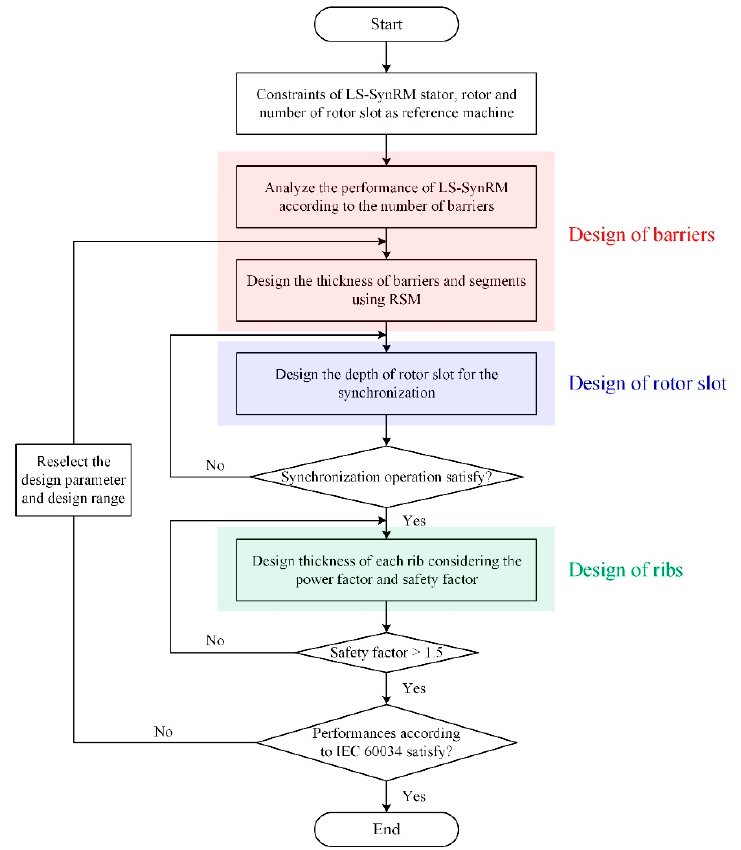
Figure 5. Design process of LS-SynRM. Table 3. International Electrotechnical Committee (IEC) 60034 standard and design objective of the efficiency and power factor.